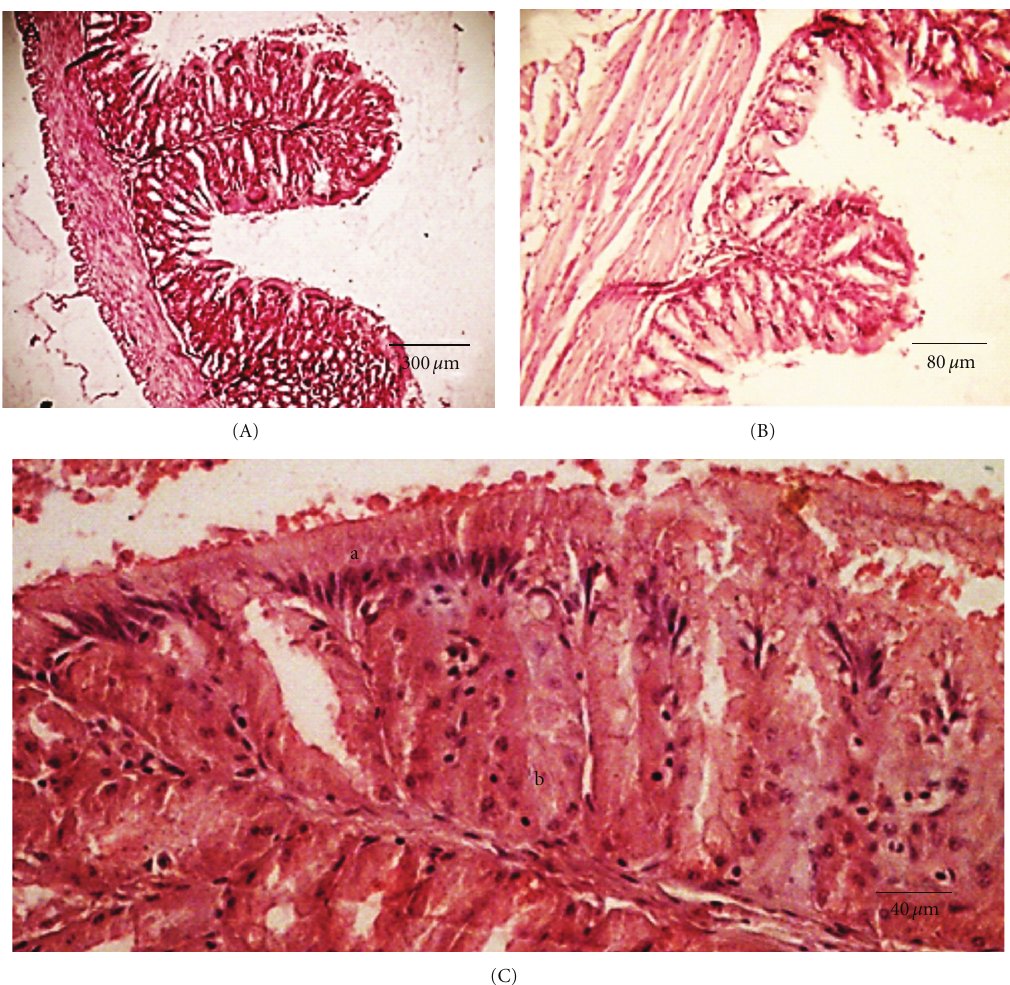
Figure 5: Fundic stomach of S. fuscus (A and B) stomach folds lower in comparison to the cardiac region; (C) simple secretory cylindrical epithelium (a) and simple tubular gastric glands